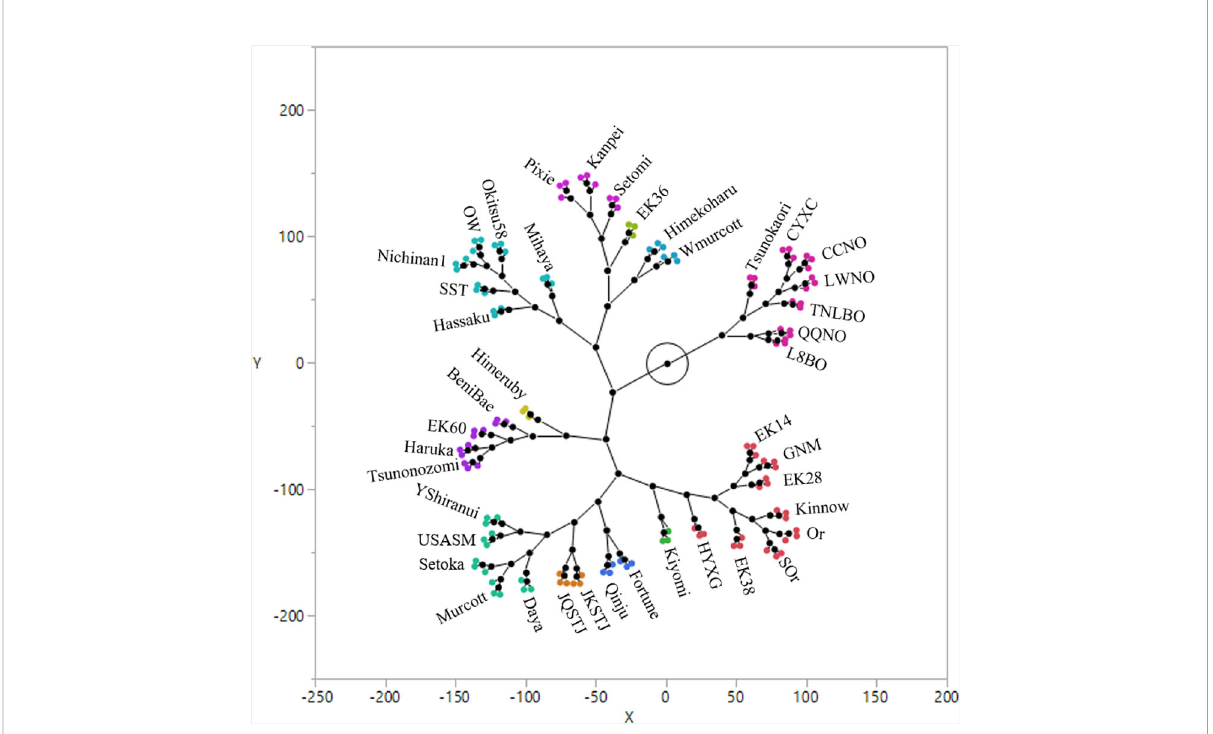
FIGURE 7 Hierarchical cluster analysis of the 42 citrus cultivars based on their leaf volatile pro fi